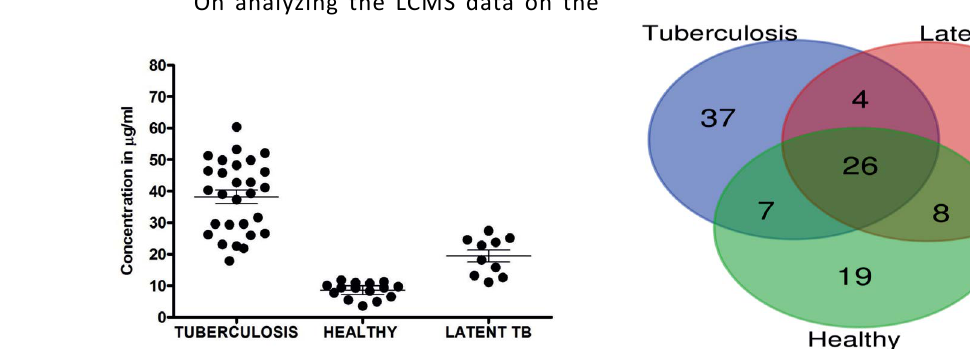
Fig. 1. Scatter dot plot showing concentration of circulating immune complexes in Healthy (n= 15), Latent TB (n= 10) and Tuberculosis patients (n = 28). The mean and standard error of mean in each group is shown by the horizontal bars.